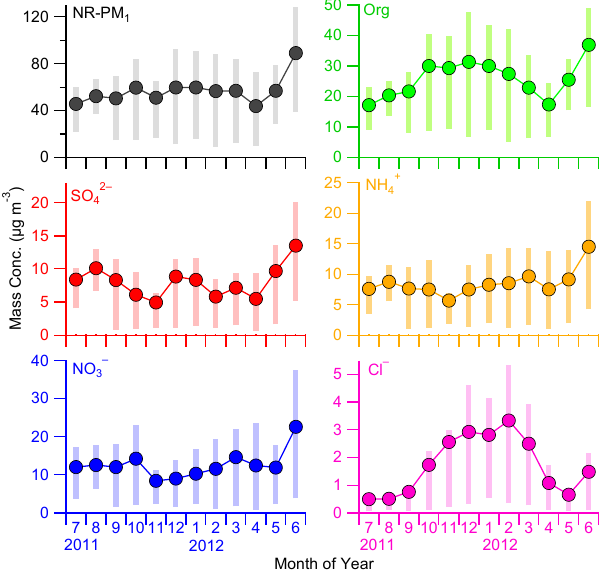
Figure 5. Seasonal variation of non-refractory submicron aerosol species. The bars represent the 25th and 75th percentiles, and the solid circles show mean